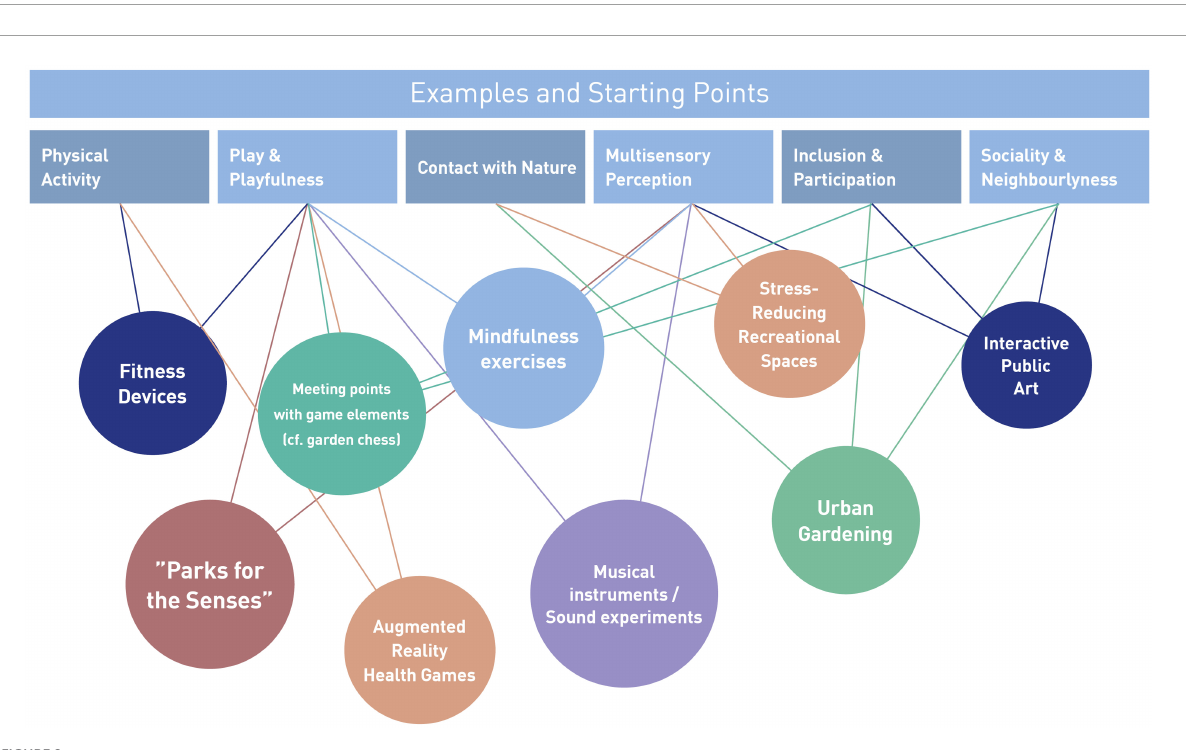
FIGURE2 Examples of starting points for small-scale urban design